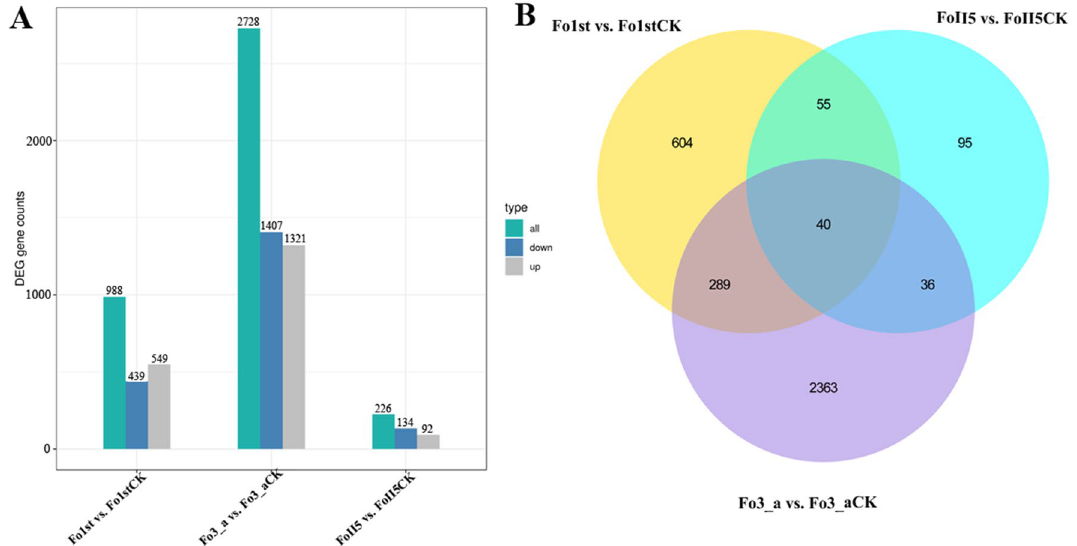
Figure 2. Overlapping Fo differentially expressed genes (DEGs) between phenamacril-resistant isolates Fo1st, Fo II5 and phenamacril-sensitive isolate Fo3_a during 1 μg/mL phenamacril treatment. ( A ) The number of DEGs in these Fo isolates. The blue column indicates the number of down-regulated DEGs, and the gray column indicates the number of up-regulated DEGs. ( B ) Venn’s diagram of DEGs in overlapping comparison groups datasets. The DEGs were identified by applying a threshold of an adjusted P -value < 0.05 and |log2 (Fold change)|> 1.‘CK’ represents the control groups treated with 0.1 μL/mL methanol and others represent the treatment groups treated with 1 μg/mL